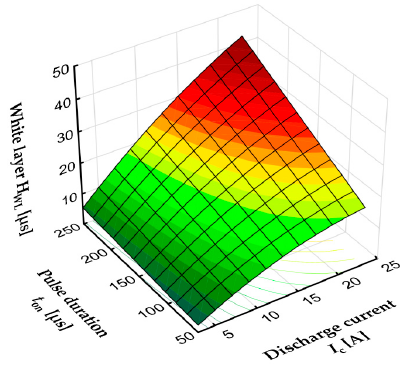
Figure 11. Estimated response surface for the average white layer thickness.